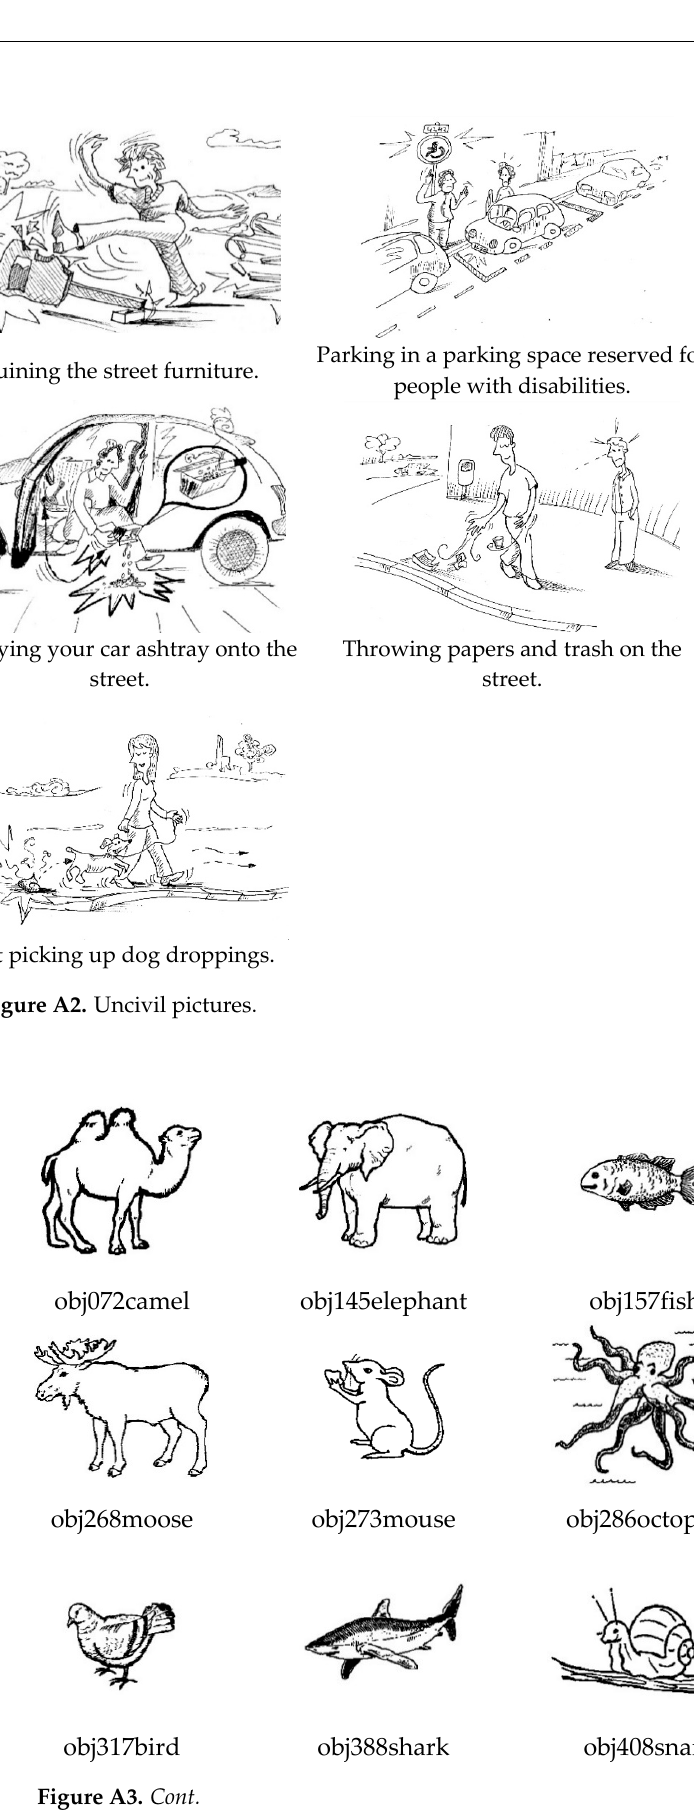
Figure A3. Animal pictures.